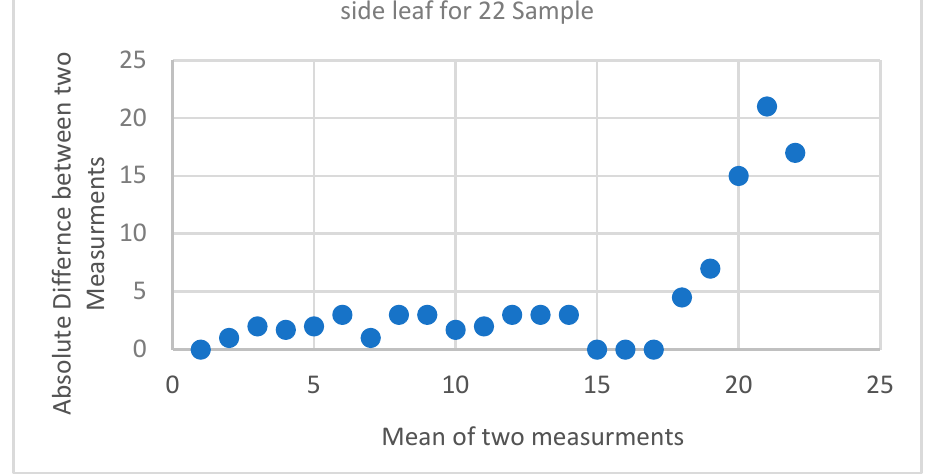
Figure 11. Average versus absolute differences in degree of crystallization of the lower surface crop for 22 calcium oxalate crystals.